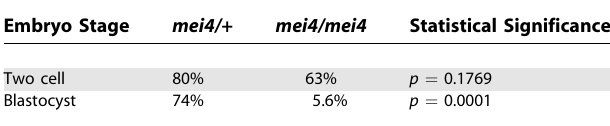
Table 1. Summary of In Vitro Fertilization Embryo